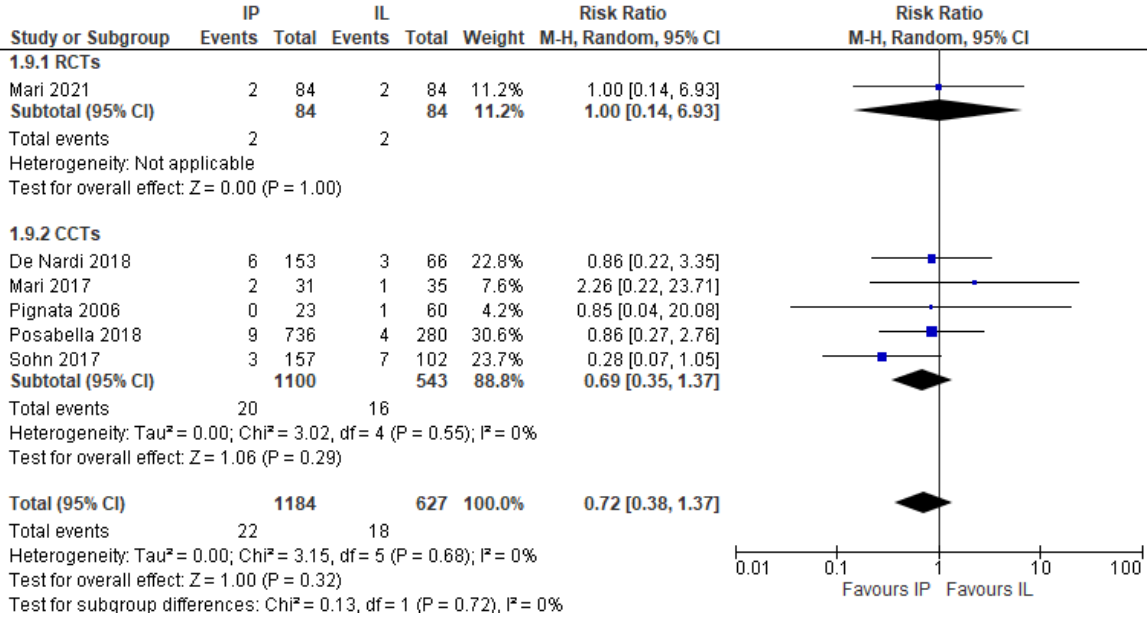
Figure 5. Anastomotic leak risk ratio in the laparoscopic sub-group. Additionally, the subgroup analyses of IMA preservation vs. high ligation and IMA preservation vs. low ligation had similar findings (RR 0.55, 95% CI 0.12 to 2.55, and RR 0.64, 95% CI 0.19 to 2.16, respectively) (Figure 6a,b).